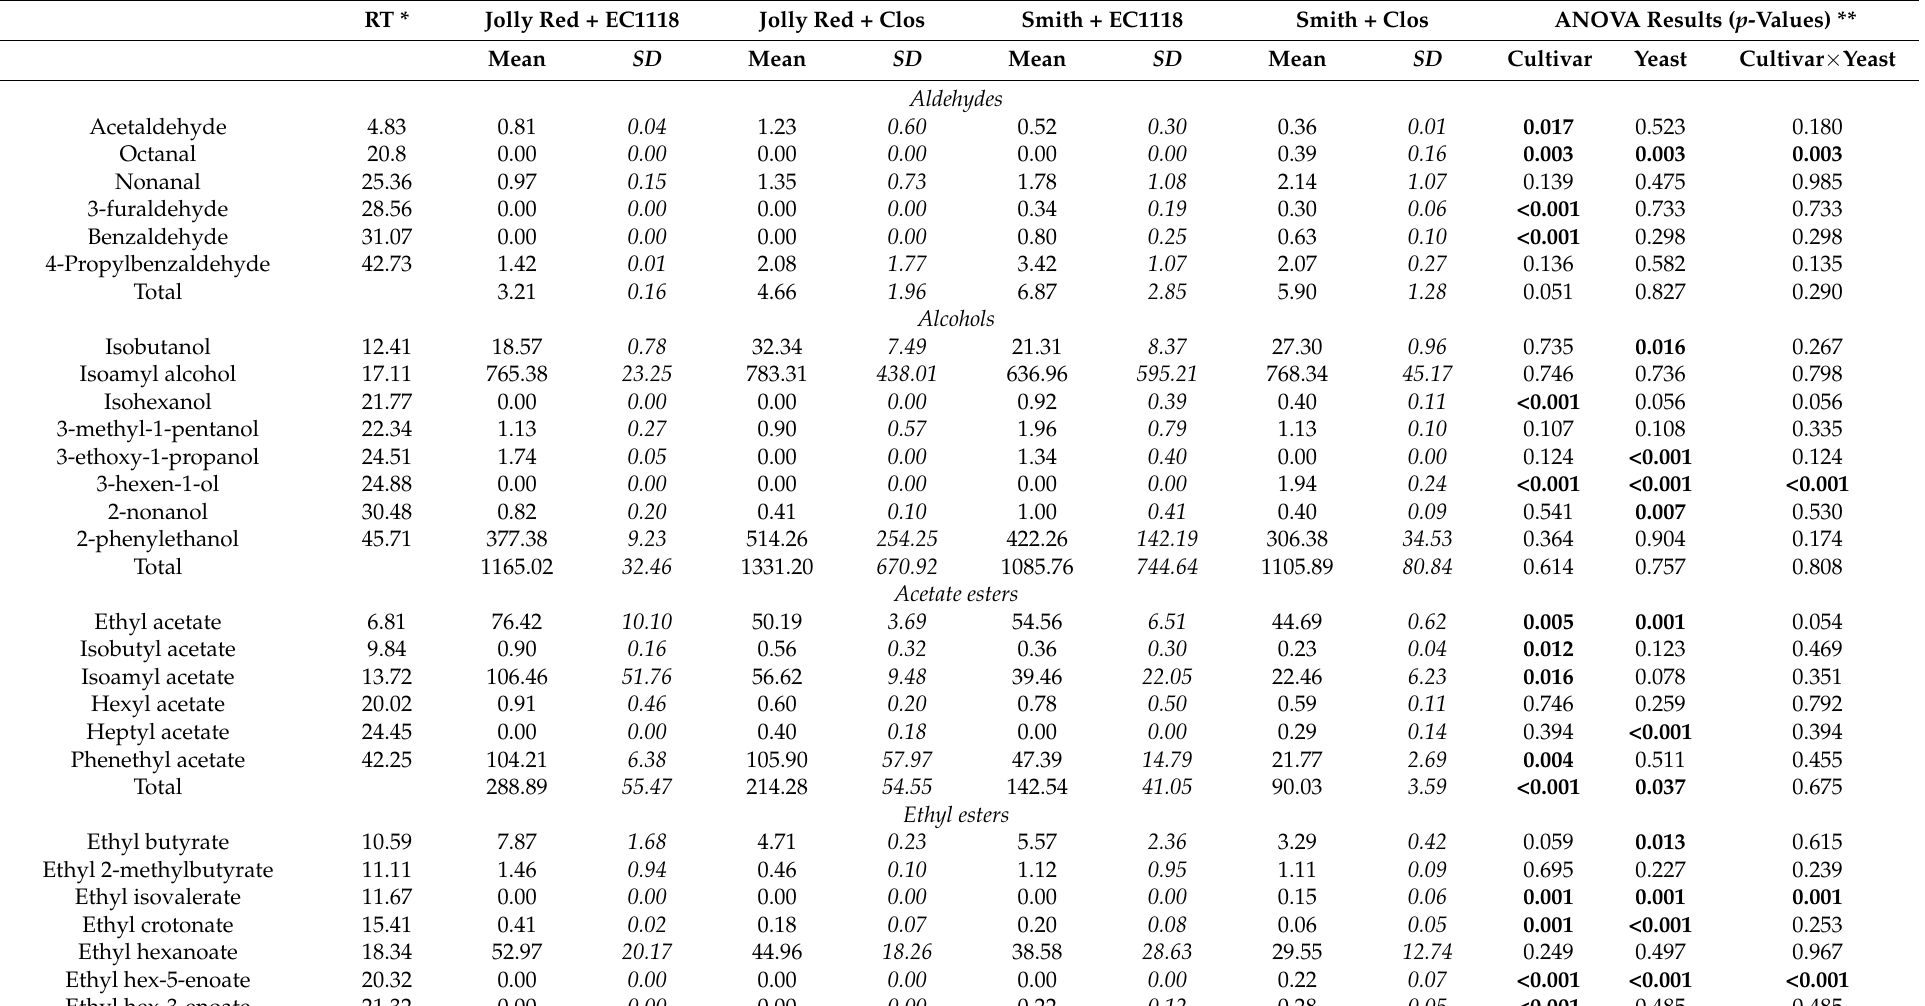
Table 5. Results of the SPME-GC/MS analysis of the headspace of the pomegranate wines. Amounts are expressed in micrograms of 2-octanol equivalents Liter − 1 . The results of ANOVA are also